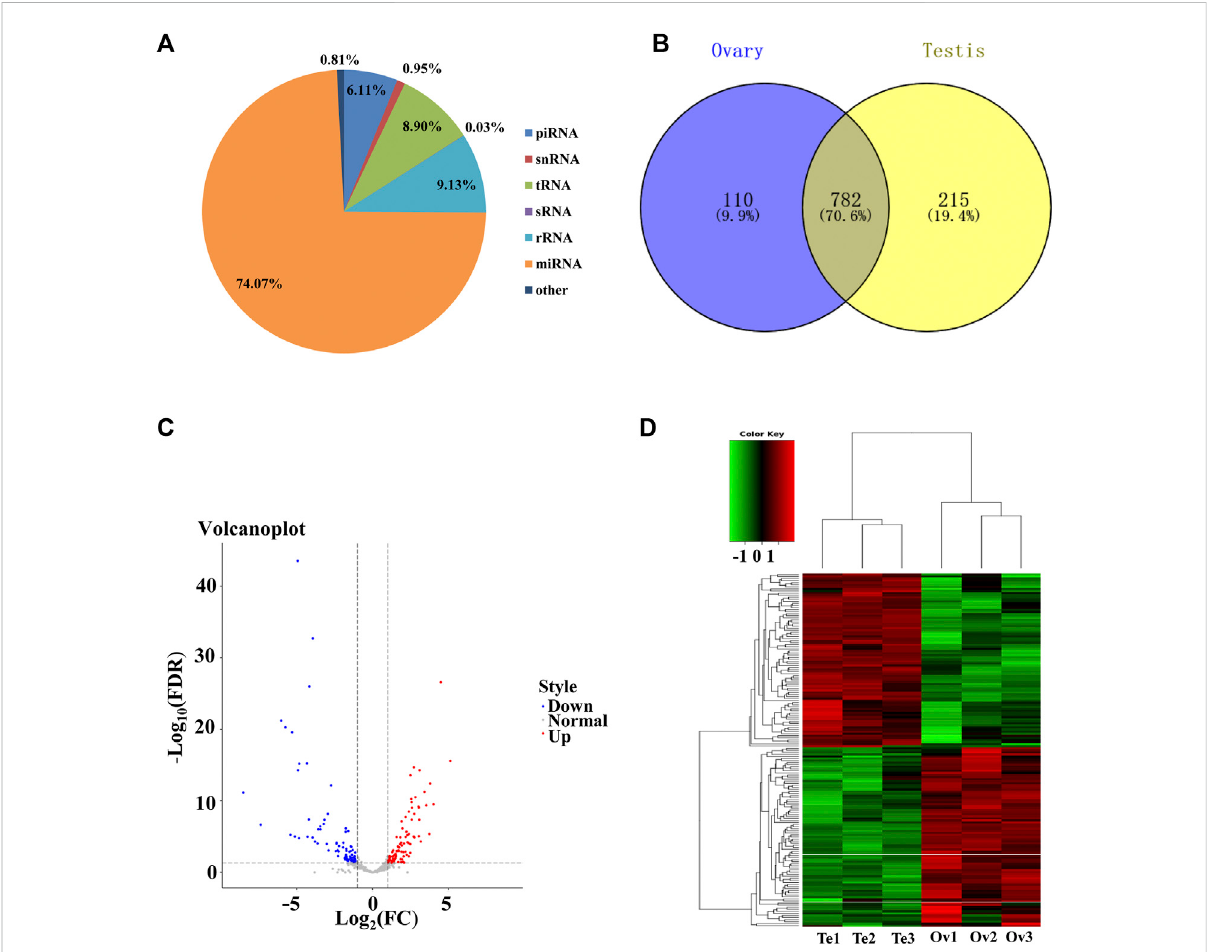
FIGURE 2 Genomic pro fi ling of the miRNAs in the gonads of Collichthys lucidus . (A) The proportion of the different types of RNAs annotated by the Rfam database. (B) Venn diagram showed the unique and common miRNAs identi fi ed in the ovaries and testes. (C) Volcano plot of the DE-miRNAs between the ovaries and testes of C. lucidus . The red and blue dots represent up- and downregulated DE-miRNAs in the ovaries, respectively. The gray dots represent the miRNAs without signi fi cantly differential expression. (D) Hierarchical clustering of the DE-miRNAs between the ovaries and testes of C. lucidus . Te1, Te2, and Te3 represent testis samples; Ov1, Ov2, and Ov3 represent ovary samples. The heatmap colors represent relative miRNA abundance: red and blue indicate high and low miRNA expressions,